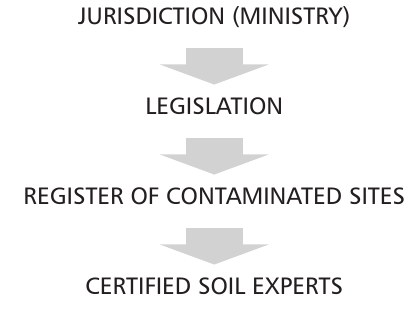
FIGURE 2. Hierarchical components of the